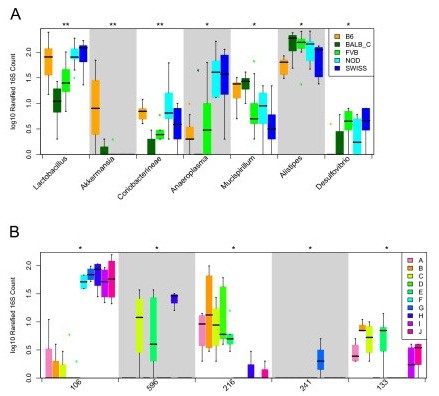
Taxa differences between genotypes and cages. (a) Several genera are significantly different in abundance between genotypes, with a cutoff of P < 0.05 and q < 0.1. (b) The significantly different OTUs between cages. On the y-axis log10 scaled rarefied 16S reads per sample are shown. OTU identifiers refer to the following taxonomic assignments: 106 = Helicobacter; 596, 216, 133 = Porphyromonadaceae; 241 = Sphingomonas.